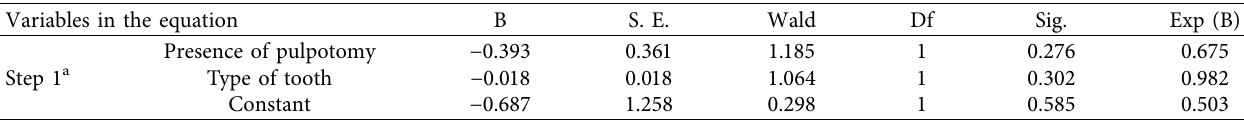
Table 2: Binomial logistic regression showing the association of the type of tooth and presence of pulpotomy to the survival outcome of the